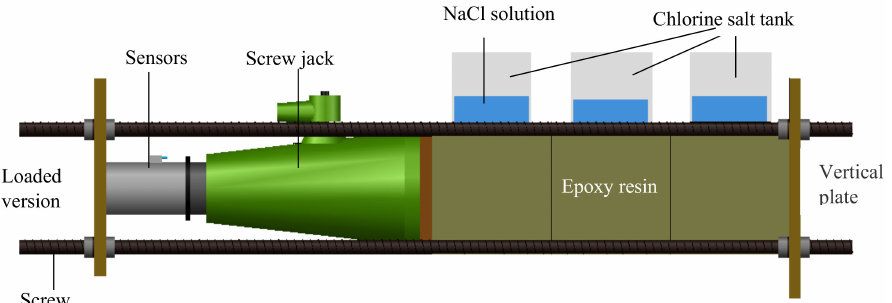
Figure 1. Uniaxial